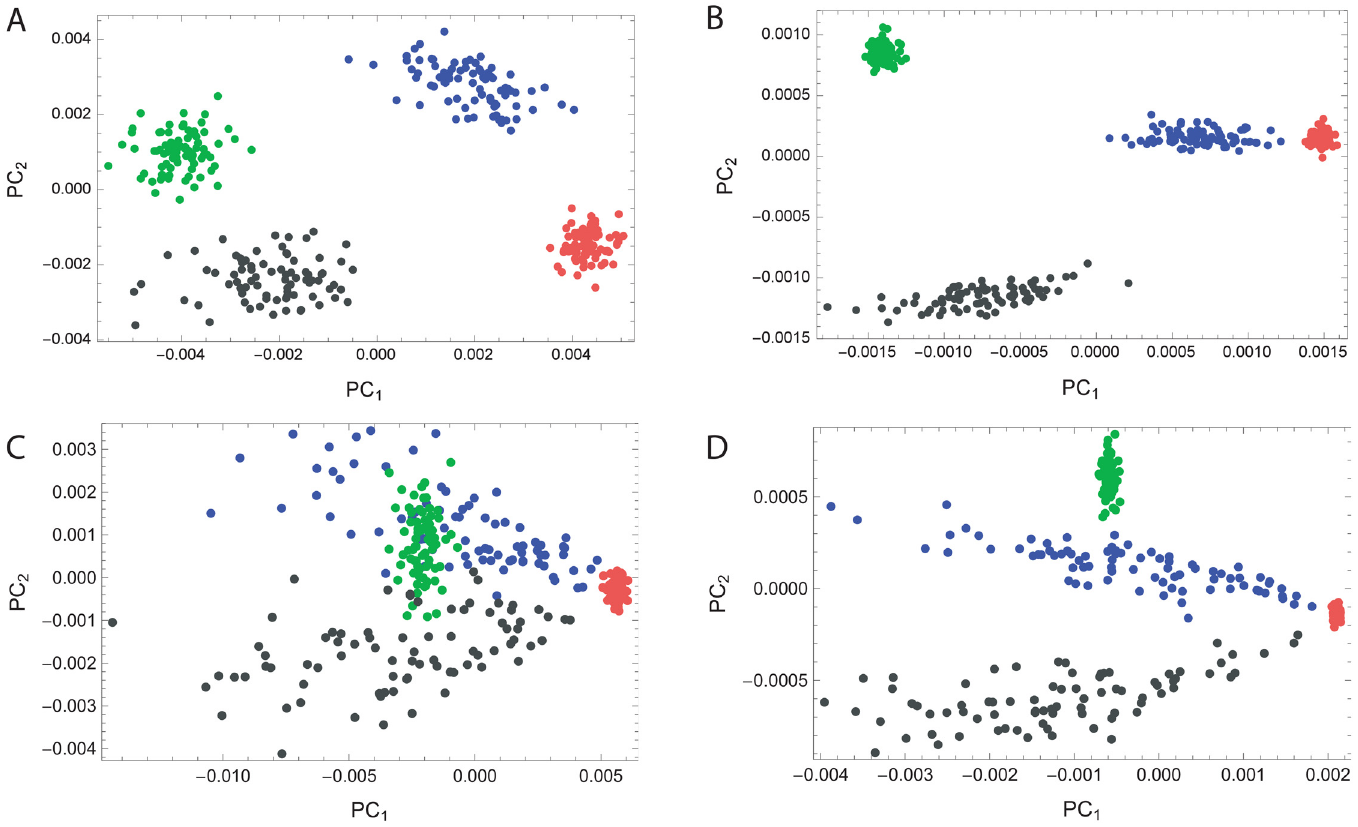
Fig 10. PCA plots from simulated SNP data of four populations (80 samples each) demonstrating the much pronounced decrease in SD S for panmictic populations (red and green) relative to structured ones (black and blue), for two different patterns of internal structure, as the number of SNP loci processed by the PCA scheme is increased. (A-B) from 1K SNPs to 8K SNPs, where structure results from some random linkage disequilibrium (LD) pattern. (C-D) from 1K SNPs to 8K SNPs, where structure results from an LD pattern resembling admixture.